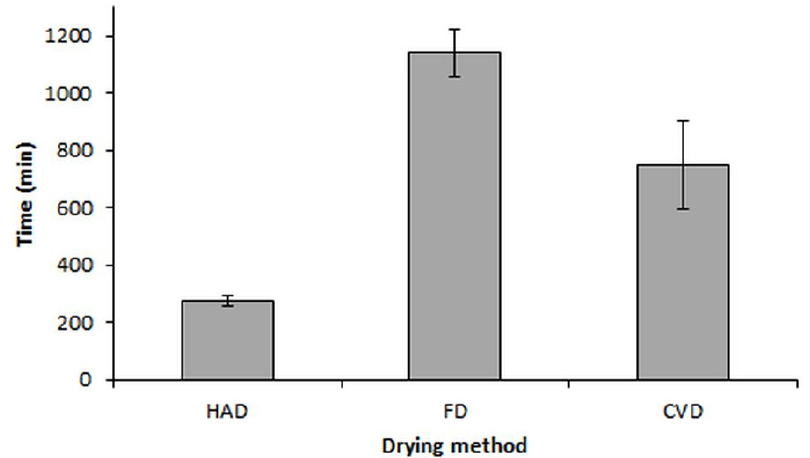
Figure 1. Total drying time of B. edulis samples under different drying methods to reach moisture content of 6.55% (HAD), 6.31% (FD) and 7.78%